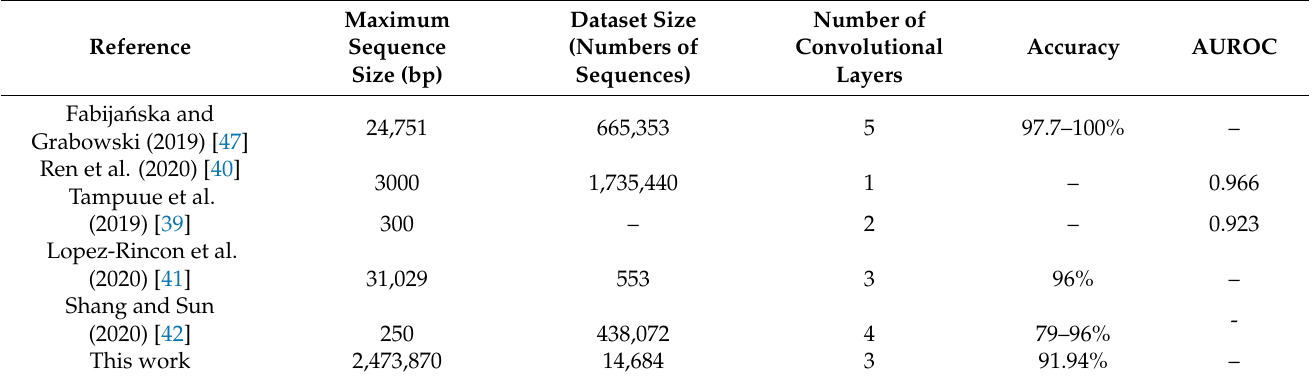
Table 4. Comparison between more recent works involving deep learning and viral